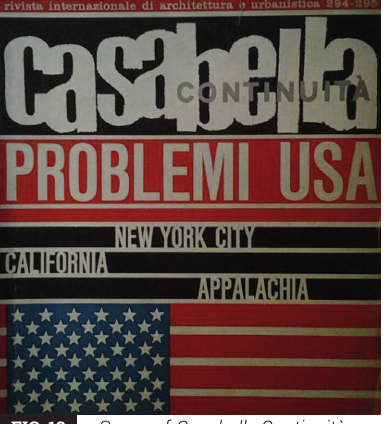
Cover of Casabella Continuità , no. 294-295